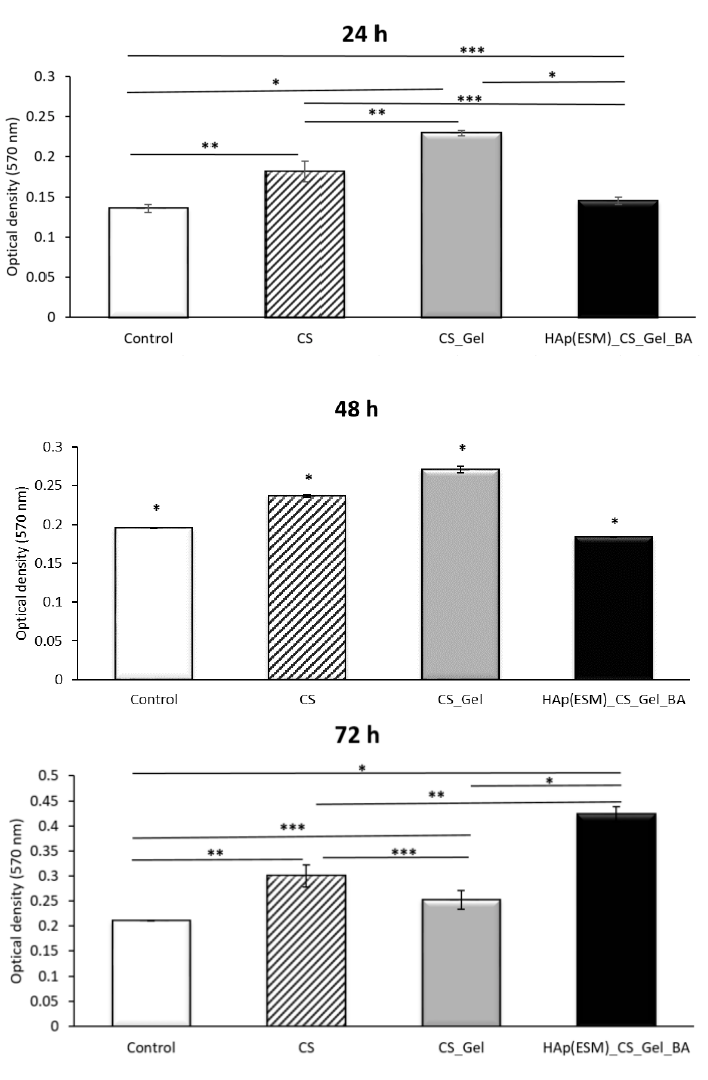
Figure 12. MTT analysis results after 24, 48 and 72 h for the CS, CS_Gel and HAp(ESM)_CS_Gel_BA porous samples (presented as mean ± S.D. of 3 replicates); * means a value p < 0.0005, ** means a value p < 0.005, *** means a value p < 0.05.